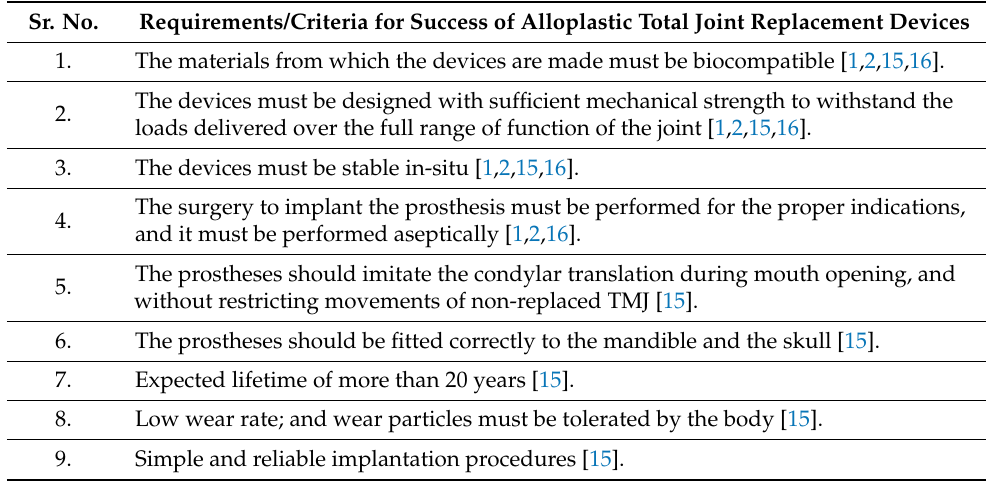
Table 2. Criteria for the successful alloplastic total reconstruction of the TMJ. Sr.